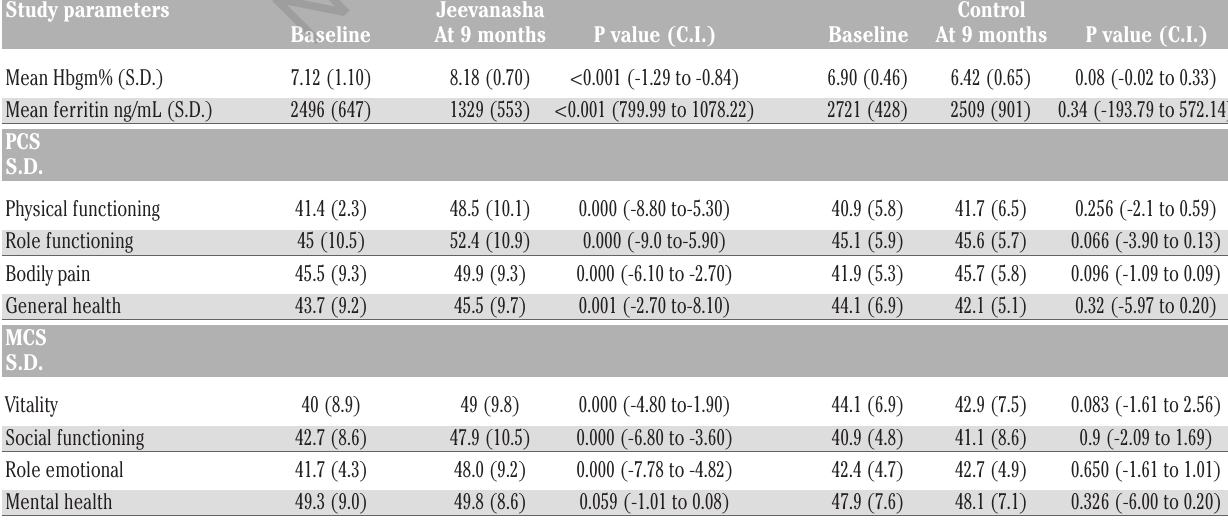
Table 2. Parameters in both the treatment arms at baseline and after 9 months of care. Study parameters Jeevanasha Control